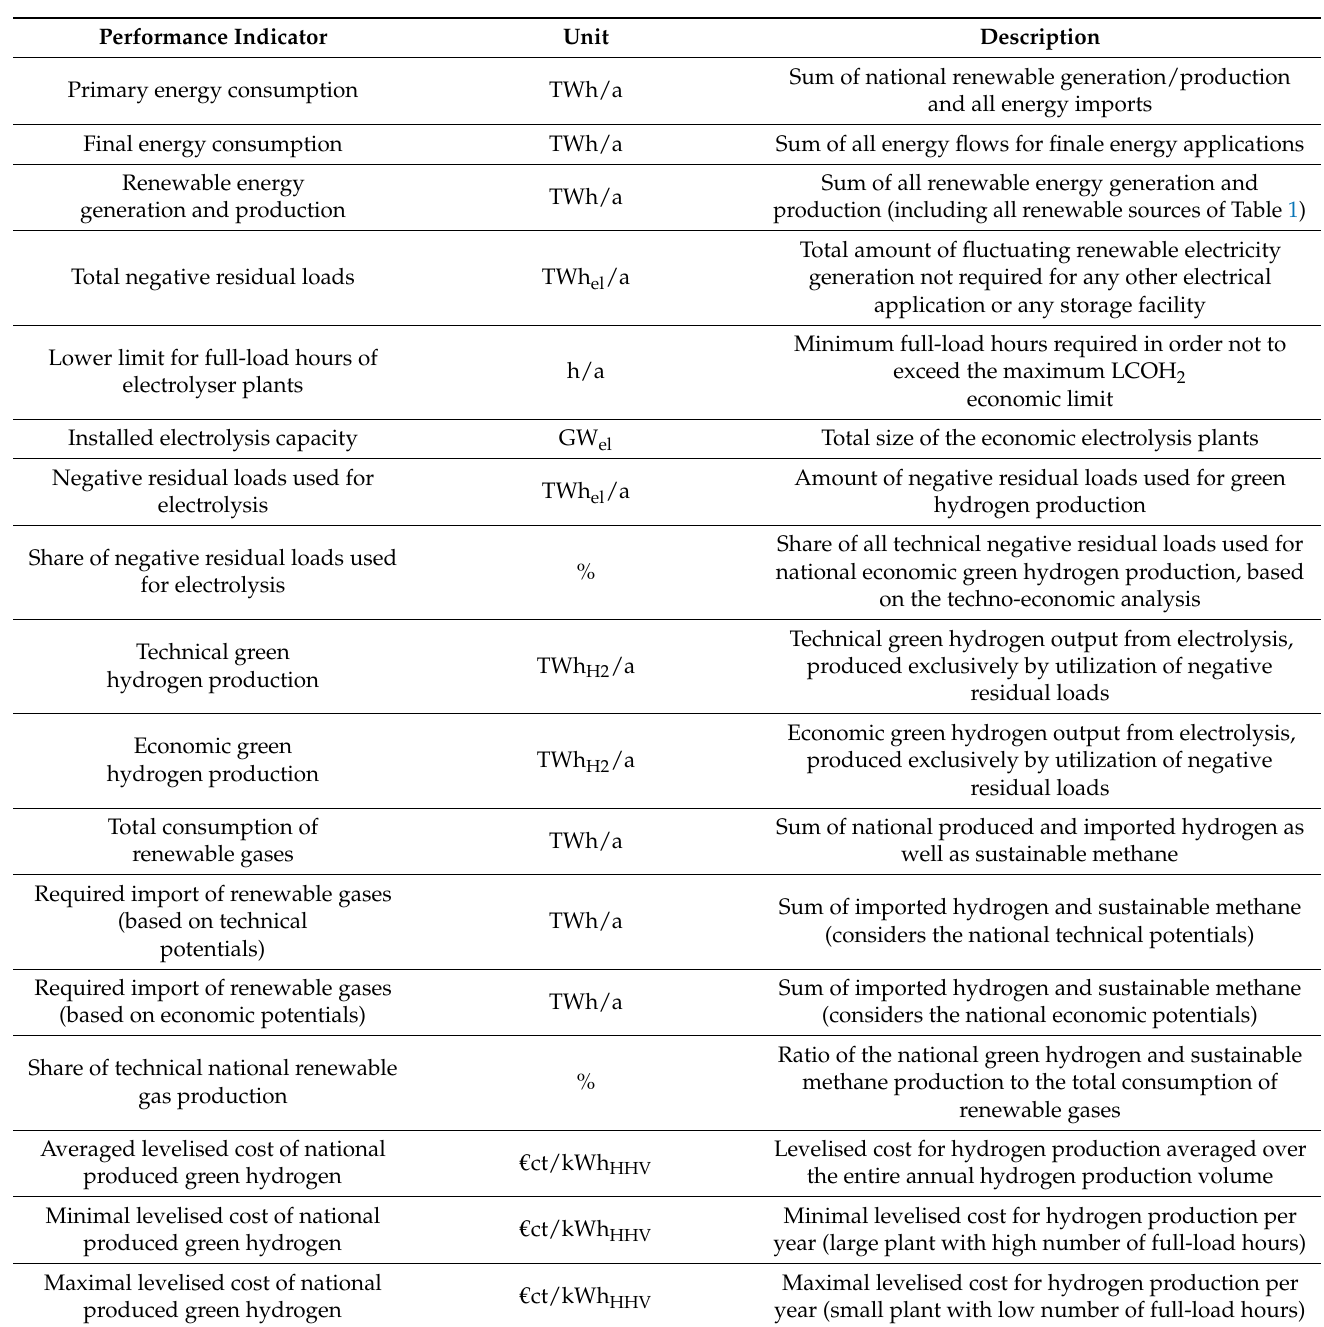
Table 3. List of performance